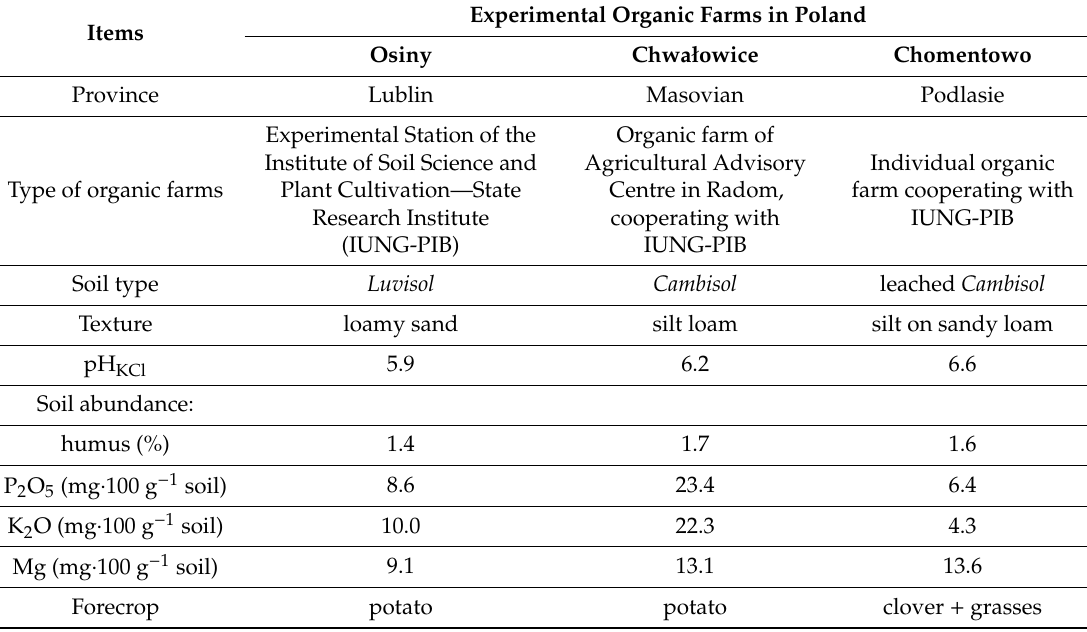
Table 1. The characteristics of habitat conditions of the